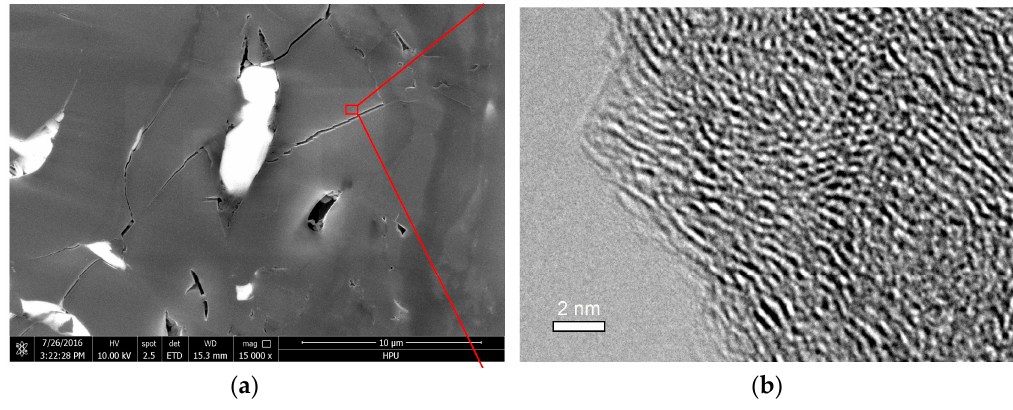
Figure 10. FE-SEM and TEM images of coal matrix. ( a ) FE-SEM image of mesopores and macropores (×15,000); and ( b ) HRTEM image of micropores (×600,000).